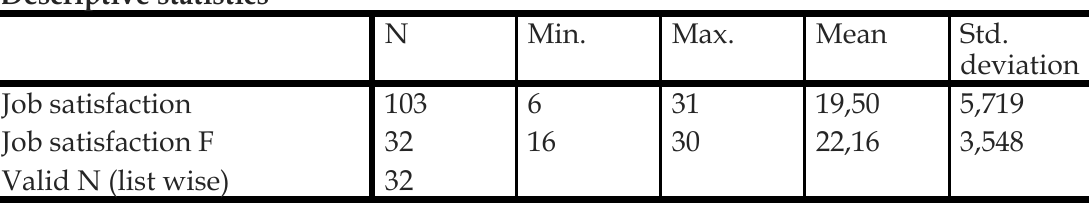
Table 4. Average level of job satisfaction in the compared